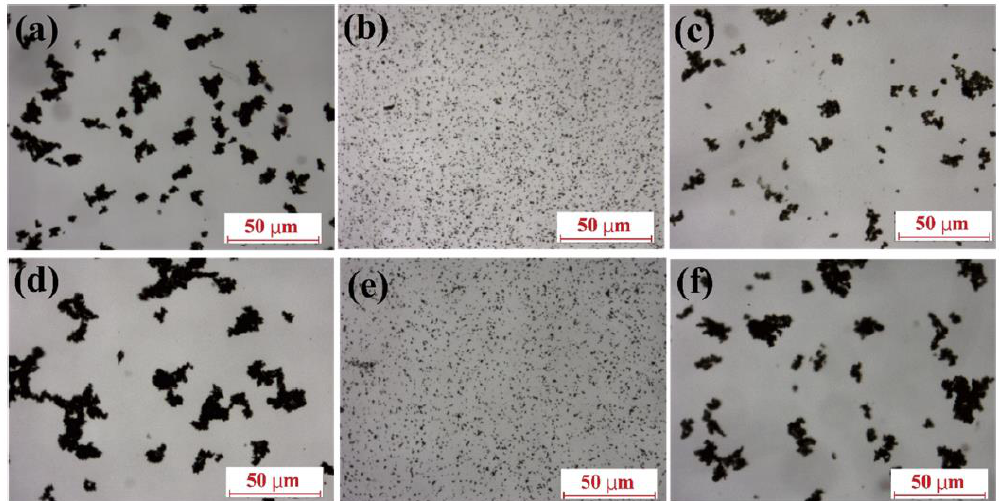
Figure 8. Optical micrographs for sulfide precipitates obtained by Xia and colleagues [92] with H 2 S in strongly acidic wastewater. ( a ) CuS; ( b ) CdS; ( c ) As 2 S 3 at 200 rpm; ( d ) CuS; ( e ) CdS; ( f ) As 2 S 3 at 50 rpm.